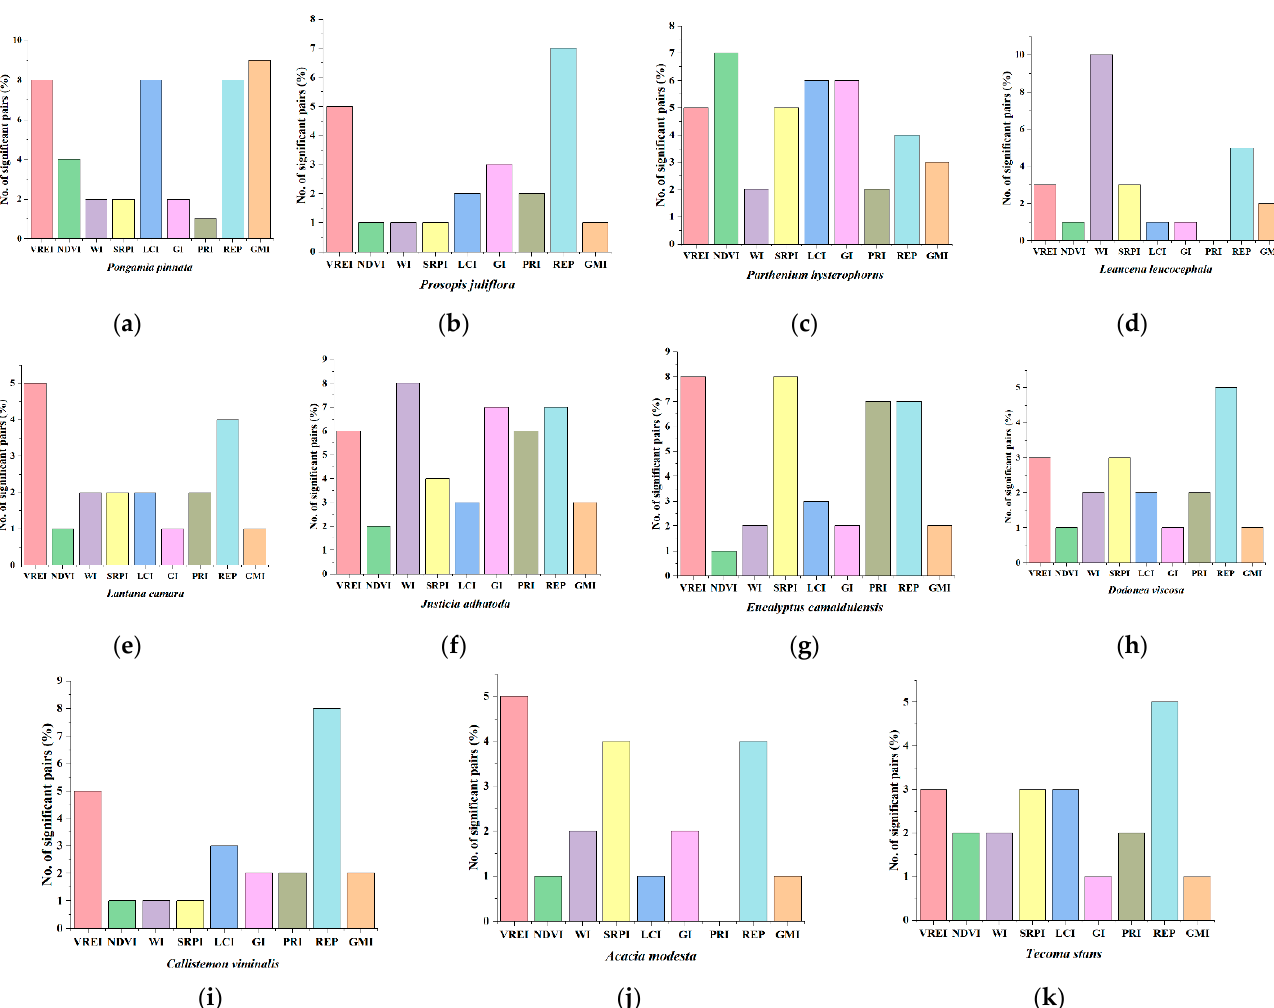
Figure 6. Graphical representation of individual plant species ( a–k ) showing the potential of discrimination with significant pair of species using different spectral indices.